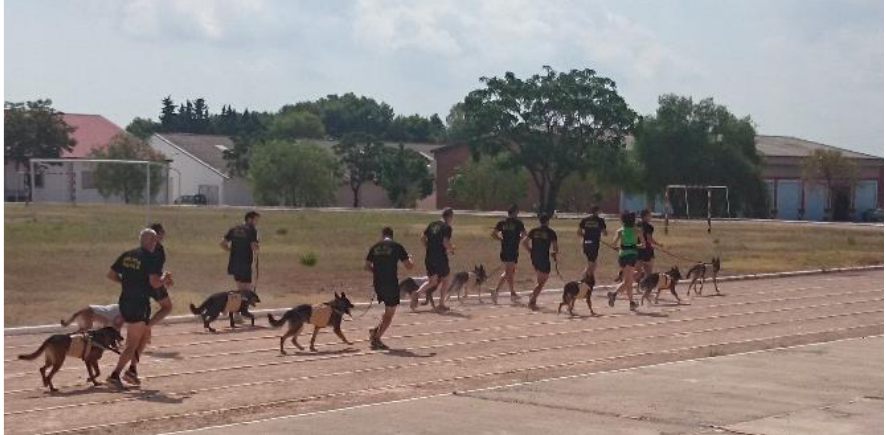
Figure 1. Image of one of the days of the clinical study. The circuit used in this clinical study was the one these dogs usually performed, on land, with a total duration of 20 min and at an average speed of 10 km/h, reaching 3.43 km.